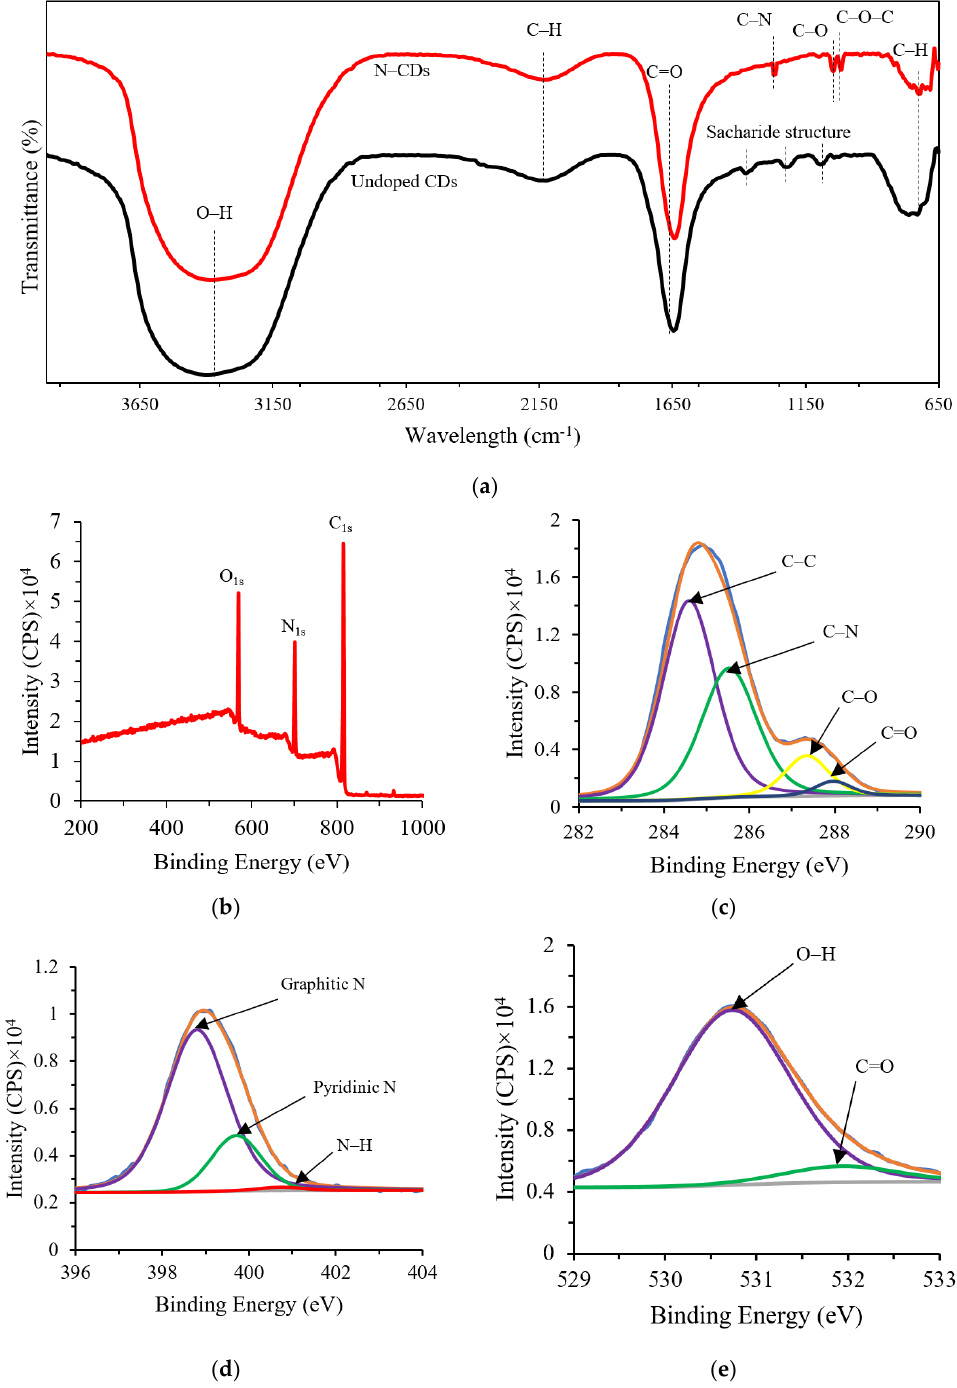
Figure 2. ( a ) FTIR analysis of undoped (black line) and N–CDs (red line), ( b ) X-ray photoelectron spectrum (XPS) of N–CDs, ( c ) high-resolution XPS for C 1s , ( d ) high-resolution XPS spectra for N 1s and ( e ) high-resolution XPS spectra for O 1s